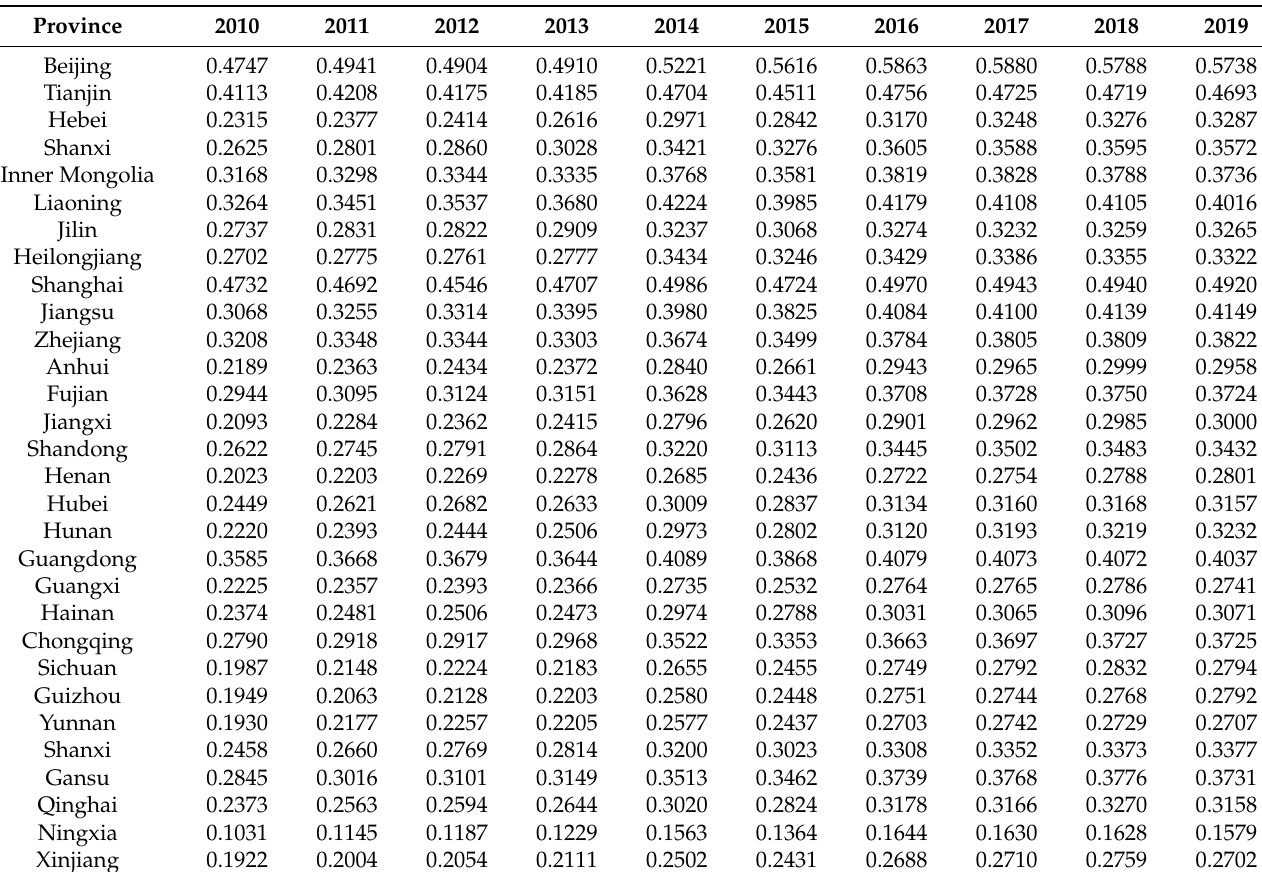
Table 1. Gini coefficient of per capita income of local residents from 2010 to